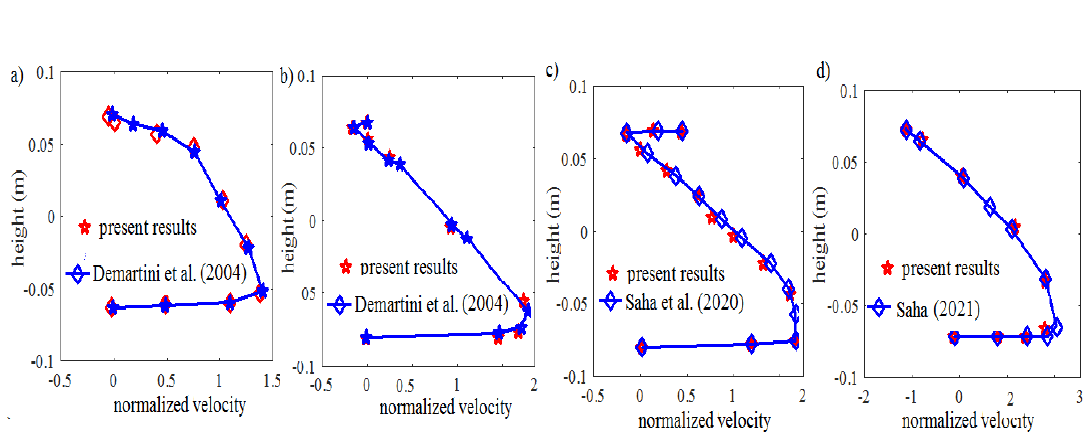
Figure 3. Profiles of normalized velocity vs. different locations at Re =